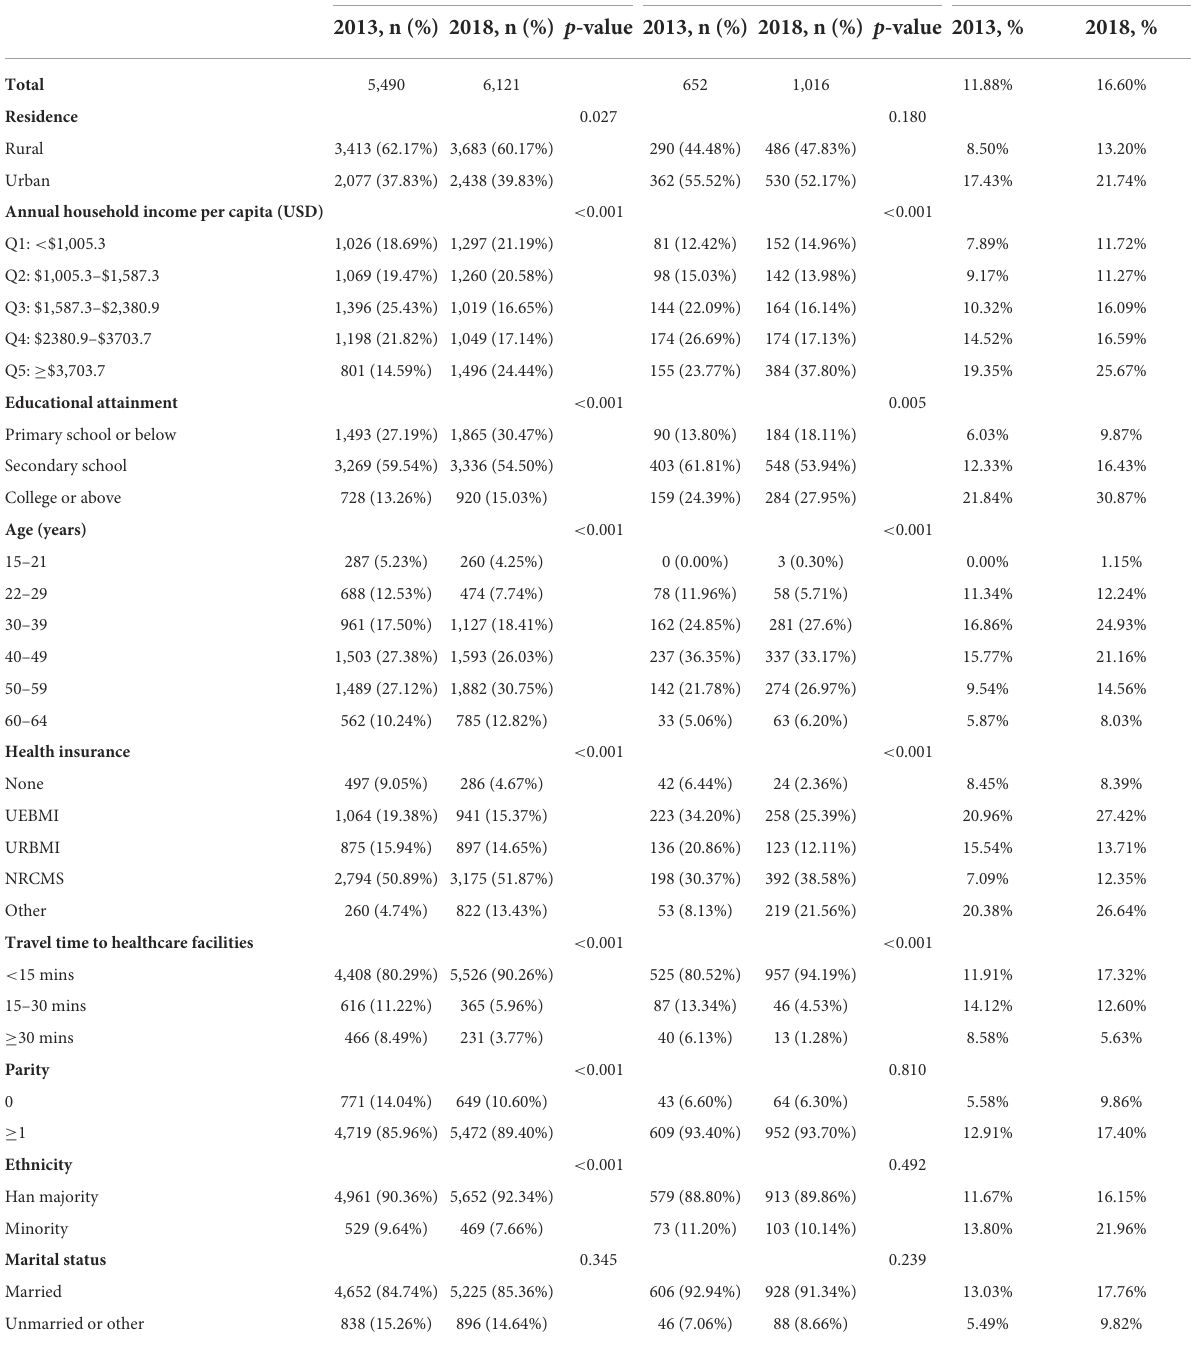
Proportion of participants underwent cervical cancer who underwent cervical screening cancer